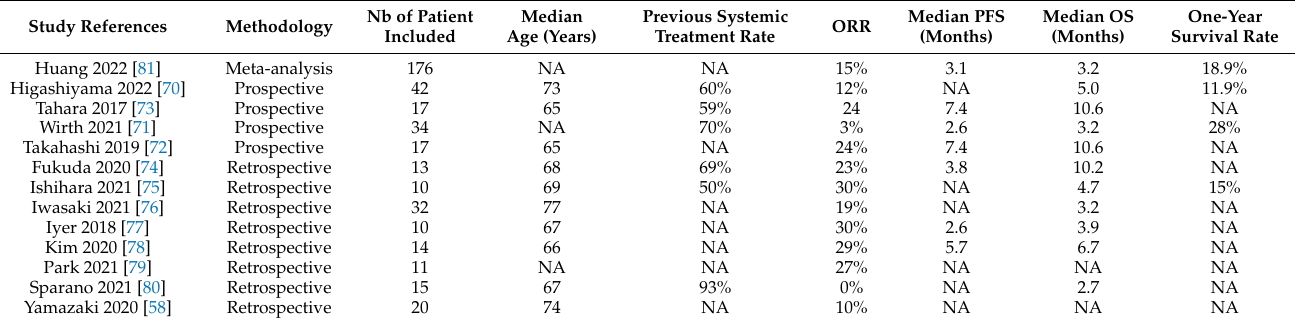
Table 2. Studies evaluating lenvatinib in anaplastic thyroïd cell